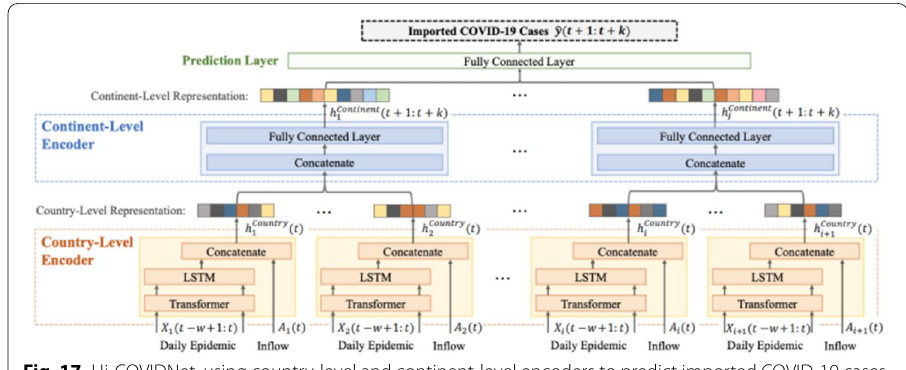
Fig. 17 Hi-COVIDNet, using country-level and continent-level encoders to predict imported COVID-19 cases from travel (Image taken from Kim et al. [133])